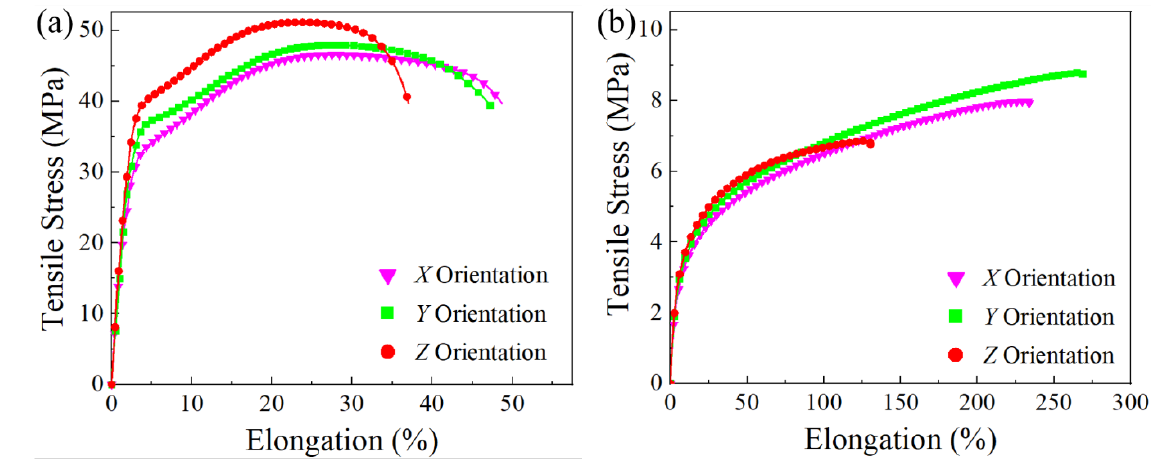
Figure 8. Stress – strain curves of tensile specimens: ( a ) PA11 and ( b ) TPU. Figure 8. Stress–strain curves of tensile specimens: ( a ) PA11 and ( b ) TPU. Table 5. Tensile properties of the PA11 and TPU